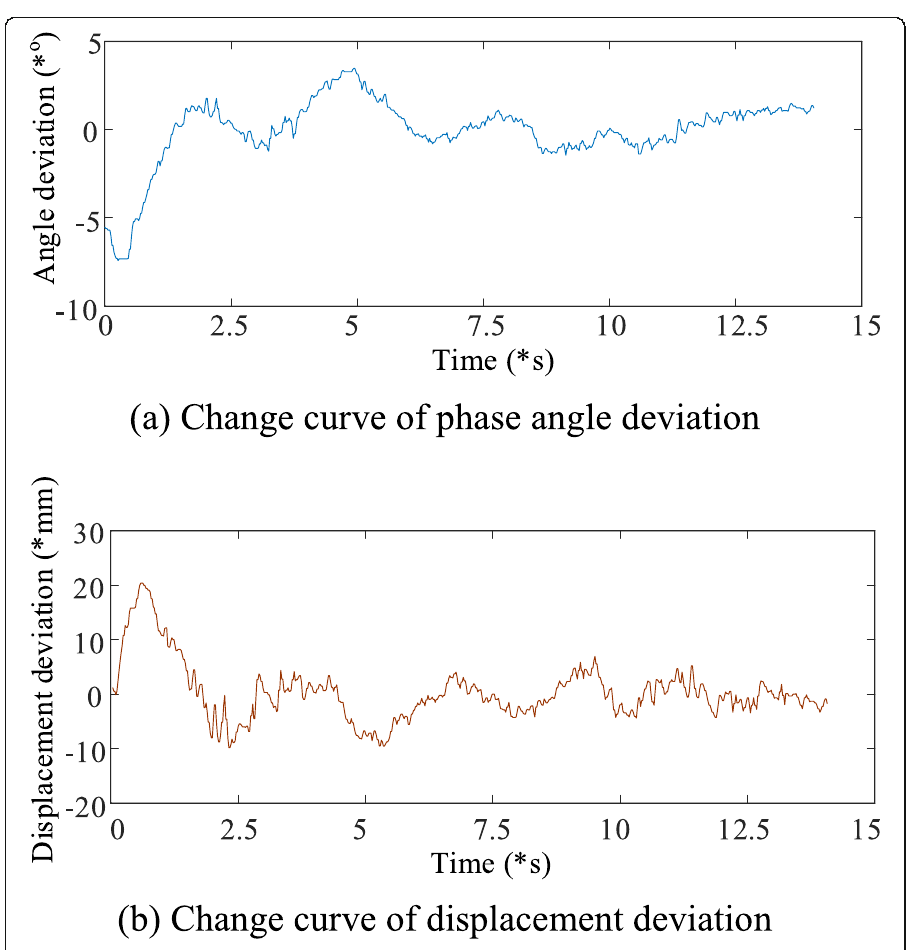
Fig. 9 Motion curve of typical scene 1. a Change curve of phase angle deviation. b Change curve of displacement